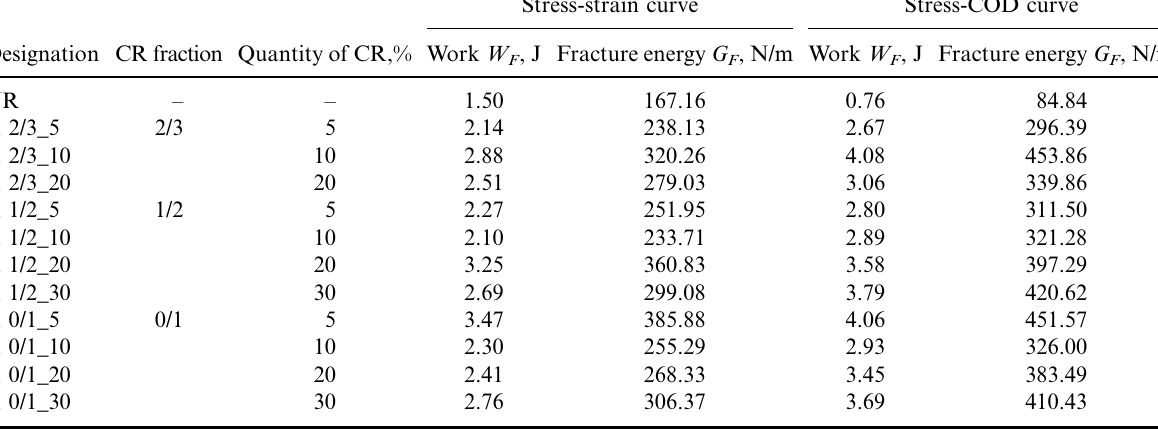
Table 3. Work and fracture energy used to break the specimens Stress-strain curve Stress-COD